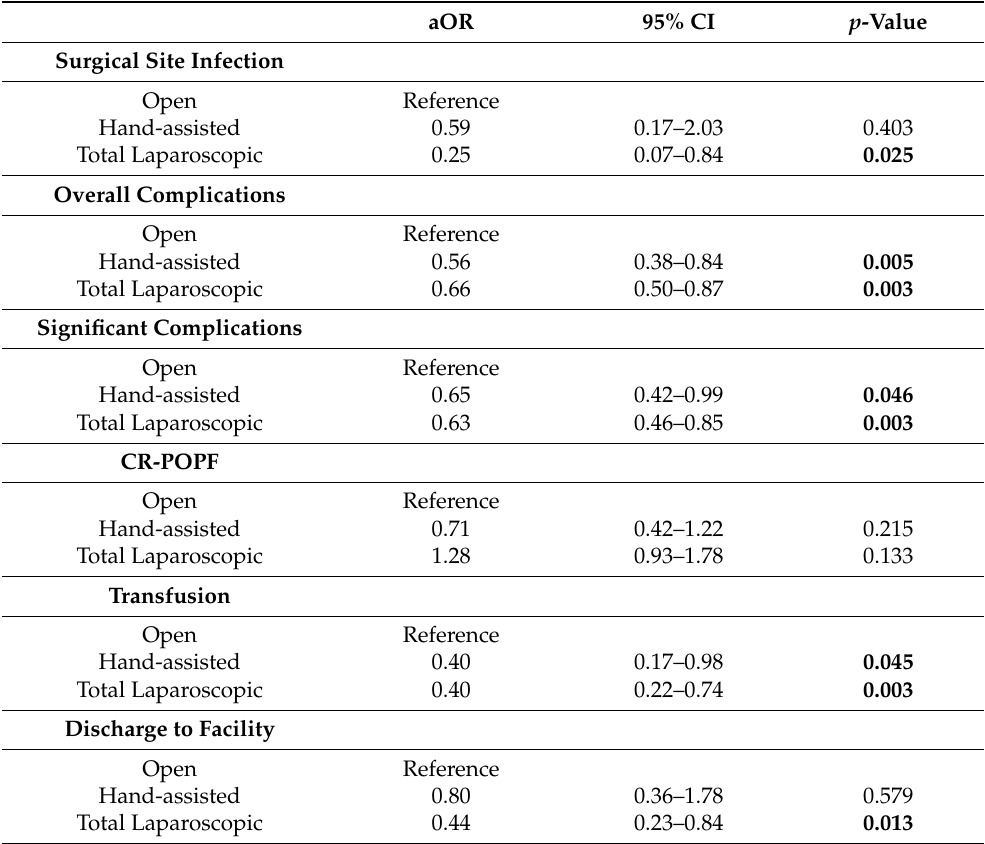
Table 3. Multivariable Logistic Regression with backward elimination of Patients Undergoing Hand- Assisted or Total Laparoscopic Compared to Open Distal